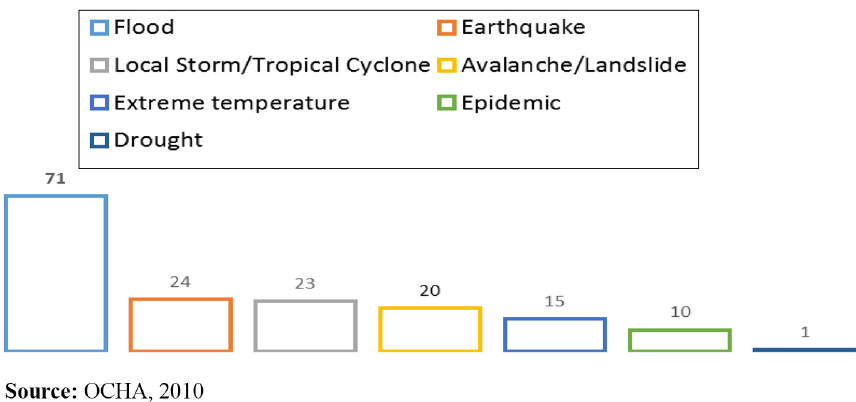
Figure 1. Number of natural disaster events in Pakistan since